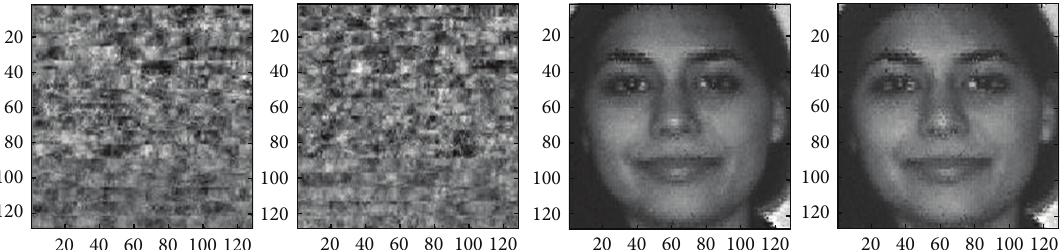
Figure 25: The four selectively encrypted frames with the last two frames decrypted.